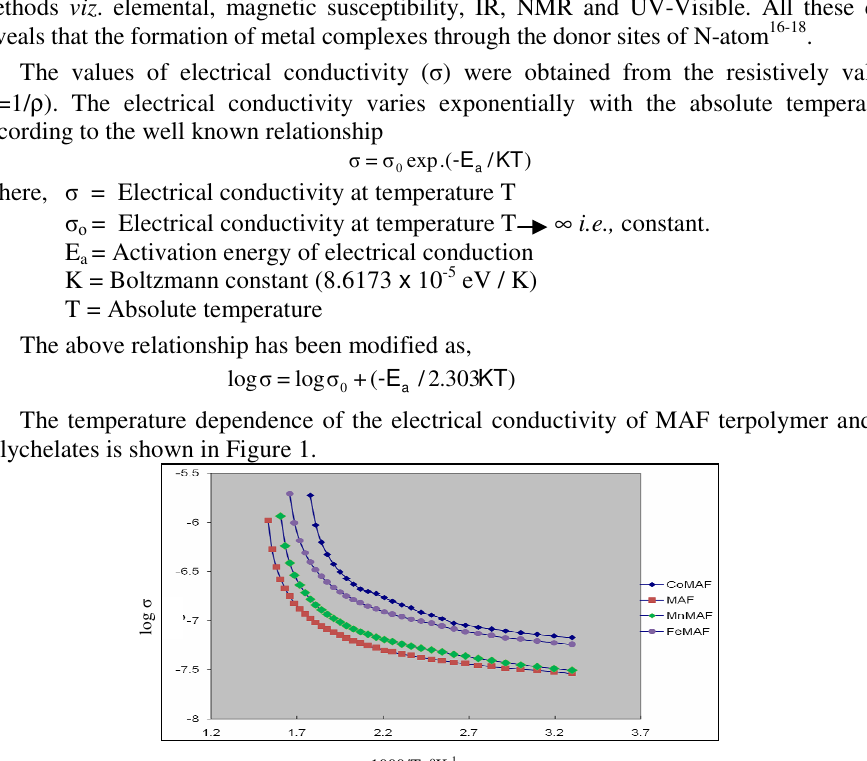
Figure 1. Temperature dependence of the electrical conductivity of MAF terpolymer and its polychelates